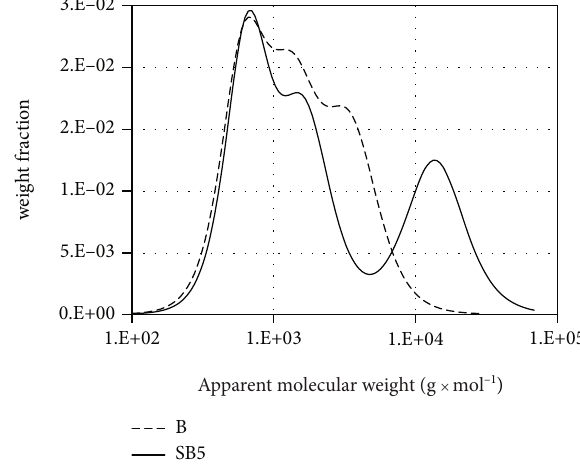
Figure 6: AMWD for the unaged binder, with and without